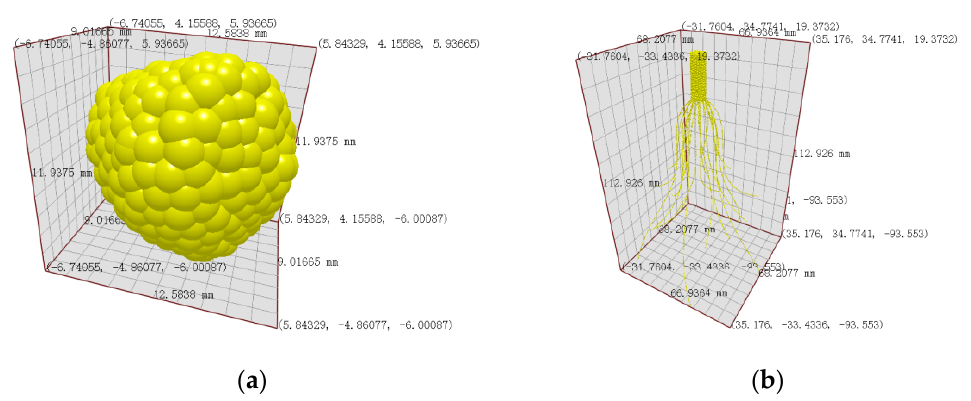
Figure 6. Construction of 3D model: ( a ) tiger nut model; ( b ) tiger nut root model.